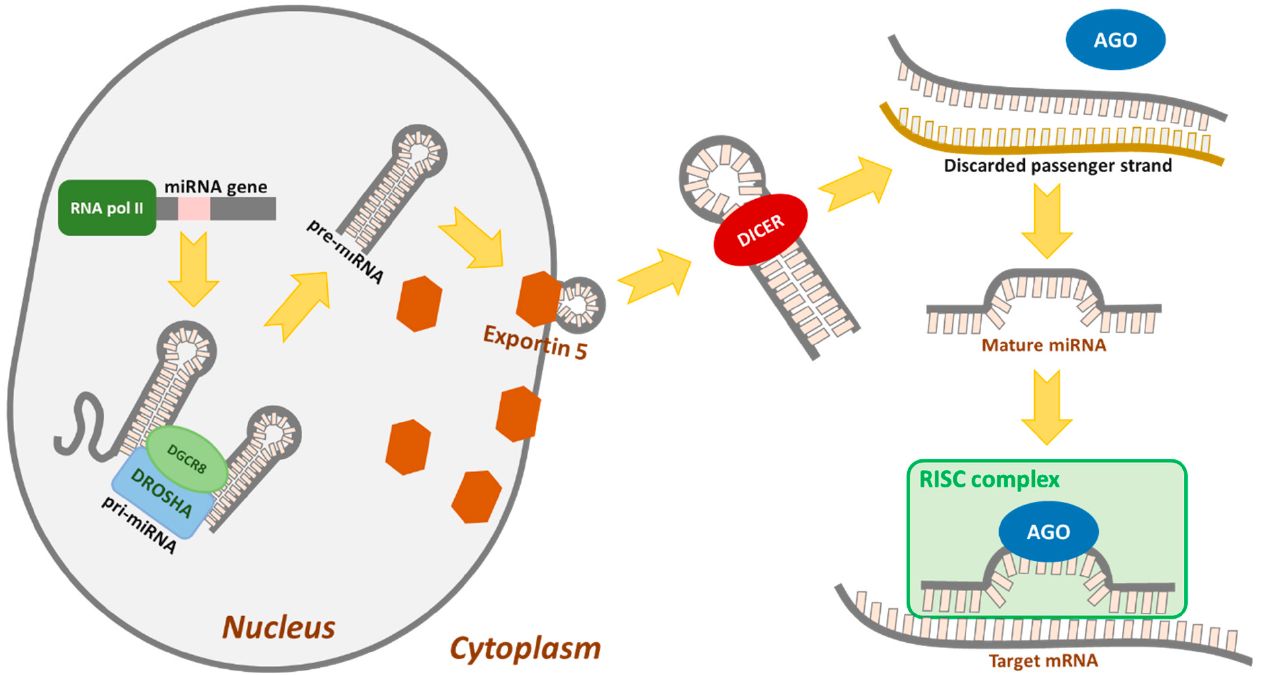
Figure 1. The main molecular steps involved in miRNA formation and organization. Table 1. Molecular functions of miRNAs in ovarian cancer.